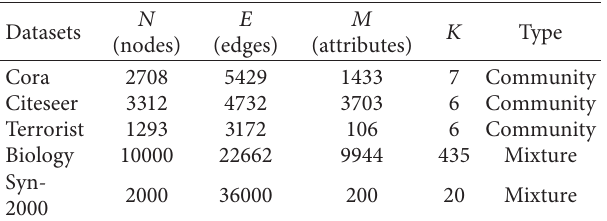
Table 2: Statistical characteristics of five networks.